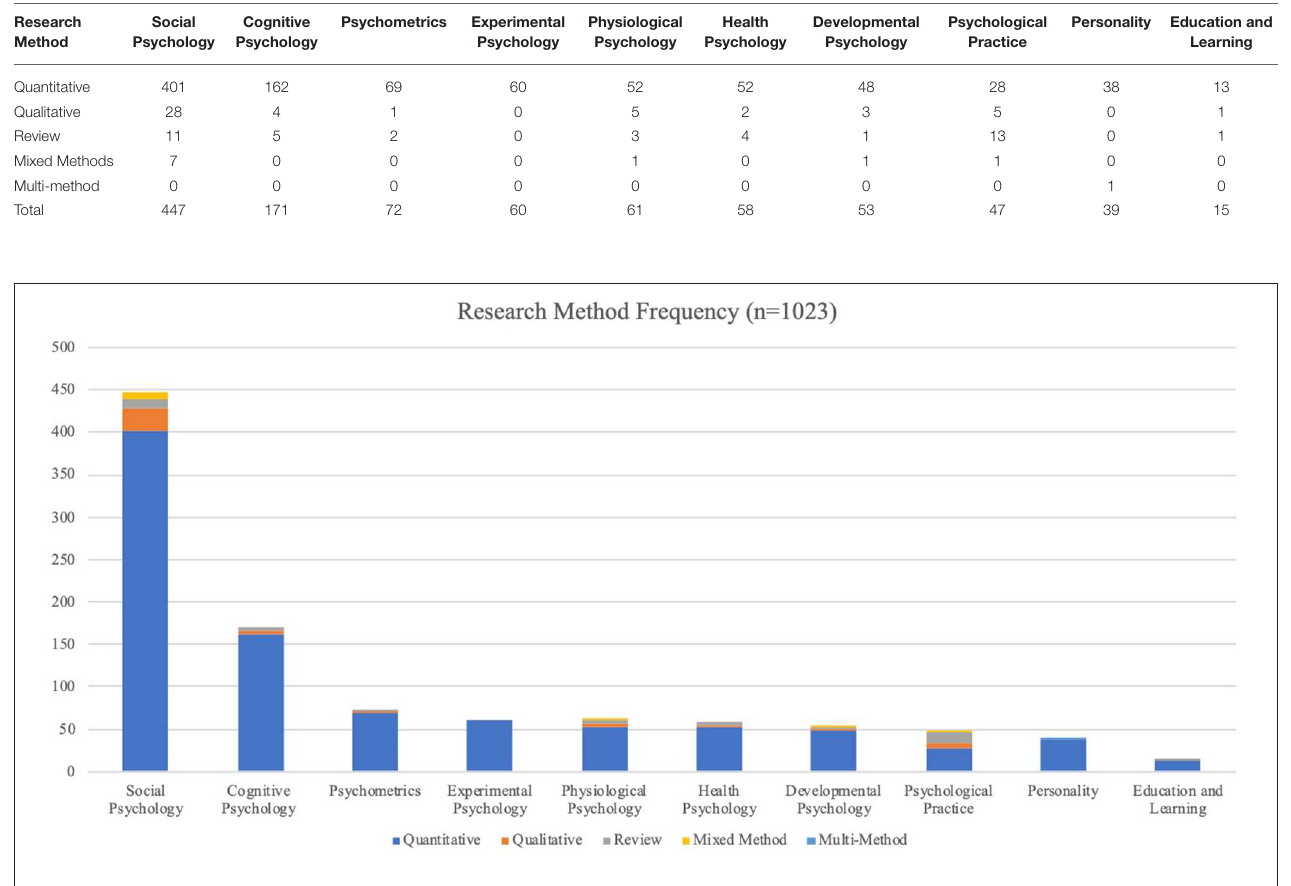
FIGURE 4 | Research method frequency in